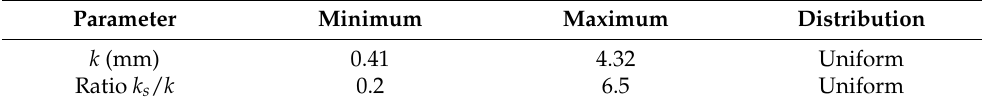
Table 1. Distribution of the input